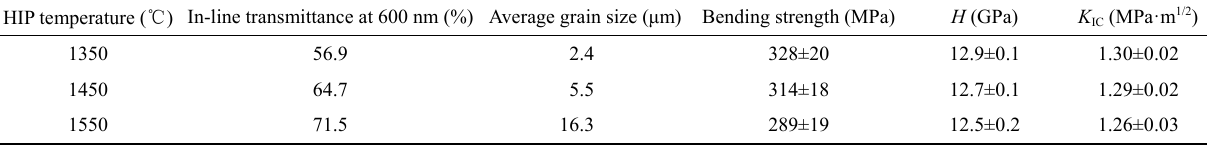
Table 1 HIP temperatures, in-line transmittances (2.5 mm in thickness), average grain sizes, bending strengths, H , and K IC of the 8YSZ transparent ceramics pre-sintered at 1280 ℃ for 4 h and HIP post-treated at 1350, 1450, and 1550 ℃ for 3 h HIP temperature ( ℃ ) In-line transmittance at 600 nm (%) Average grain size ( μ m) Bending strength